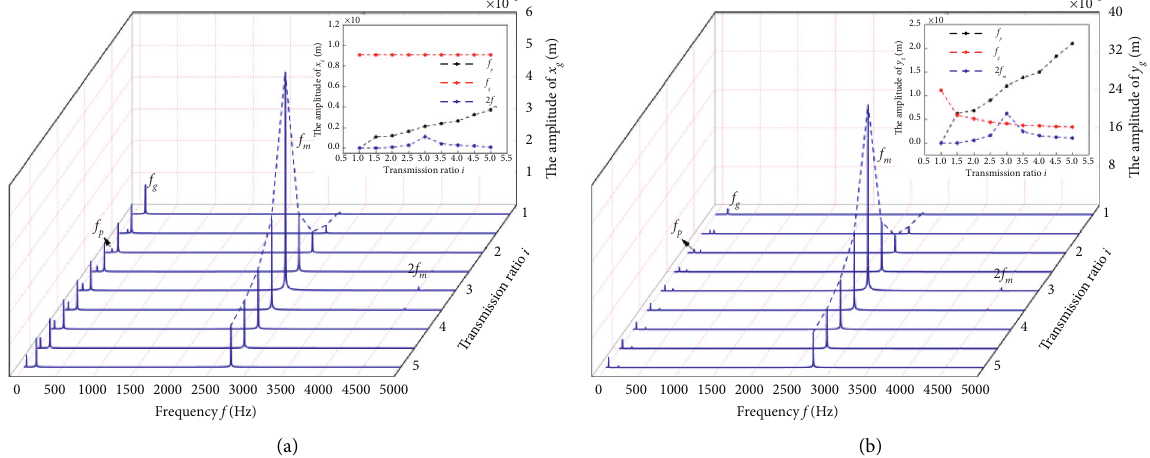
Figure 9: The spectrum waterfall diagram of the driven gear: (a) in x direction and (b) in y